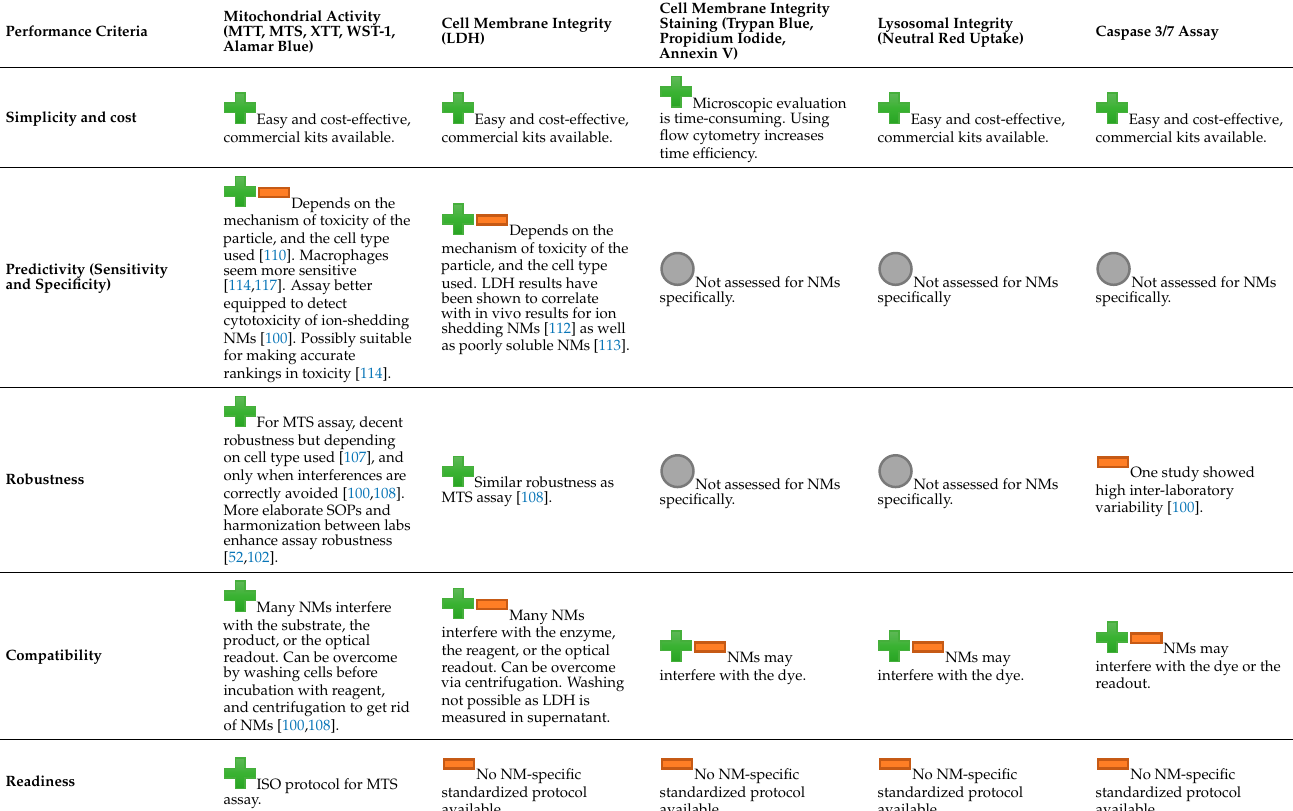
Table 1. Evaluation of suitability of cytotoxicity assays for SbD hazard testing.